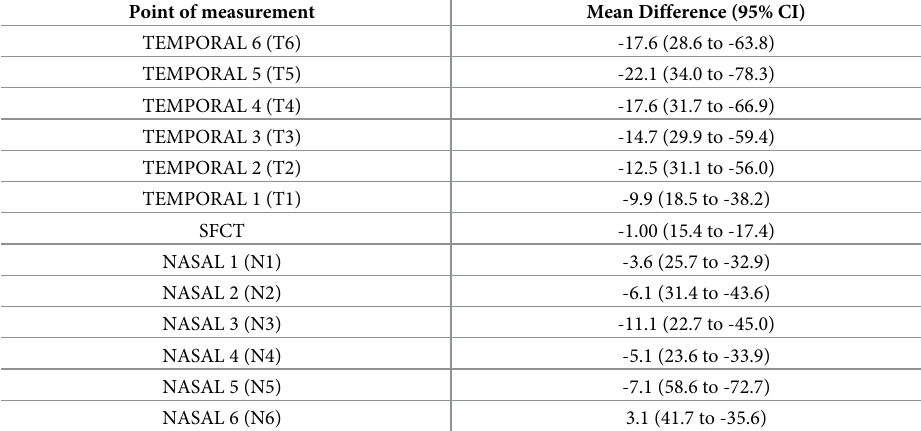
Table 5. Mean difference between the two observers for CT